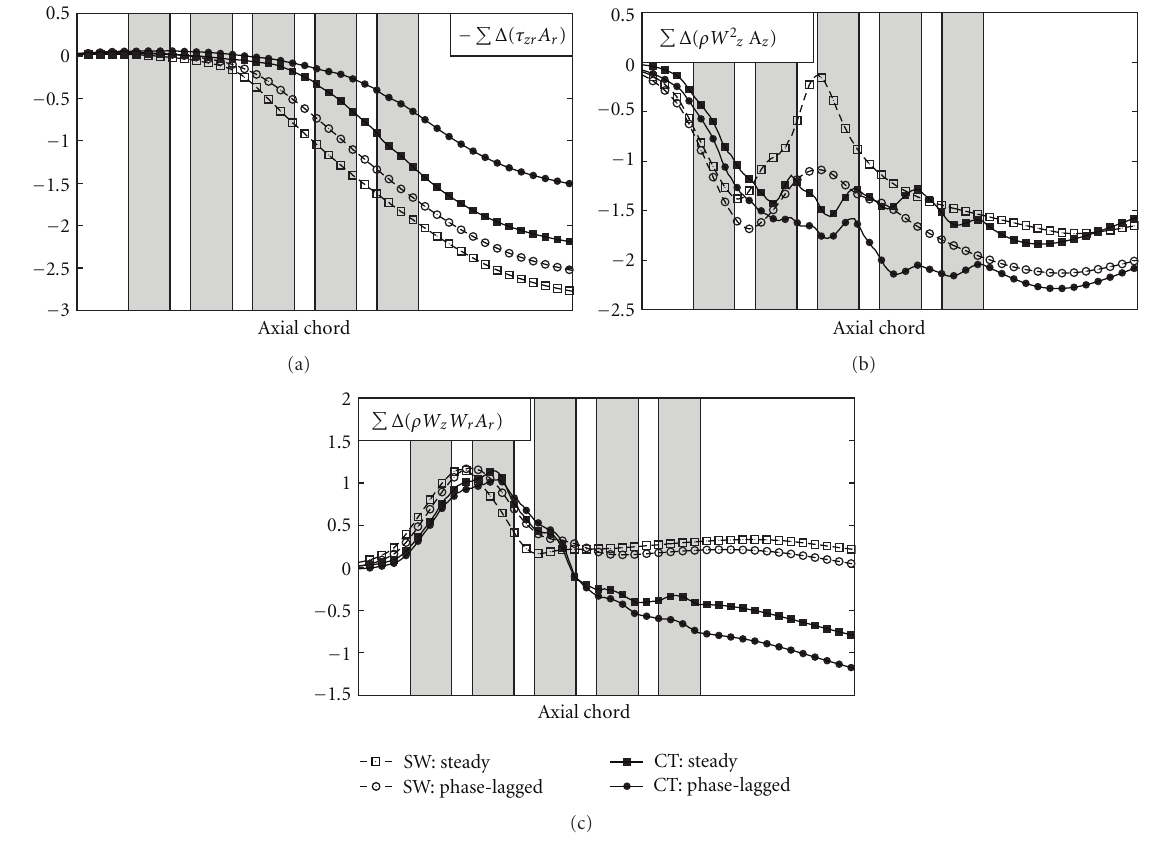
Figure 17: CREATE-R2 with and without CT: cumulative sum in the axial direction of the principal terms involved in the axial momentum equation [37].